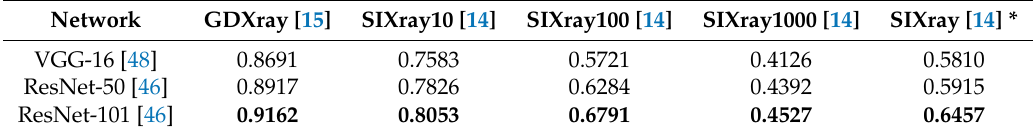
Table 3. Performance of proposed detection framework in terms of mAP on GDXray [15] and SIXray [14] datasets using different classification backbones. Bold indicates the best